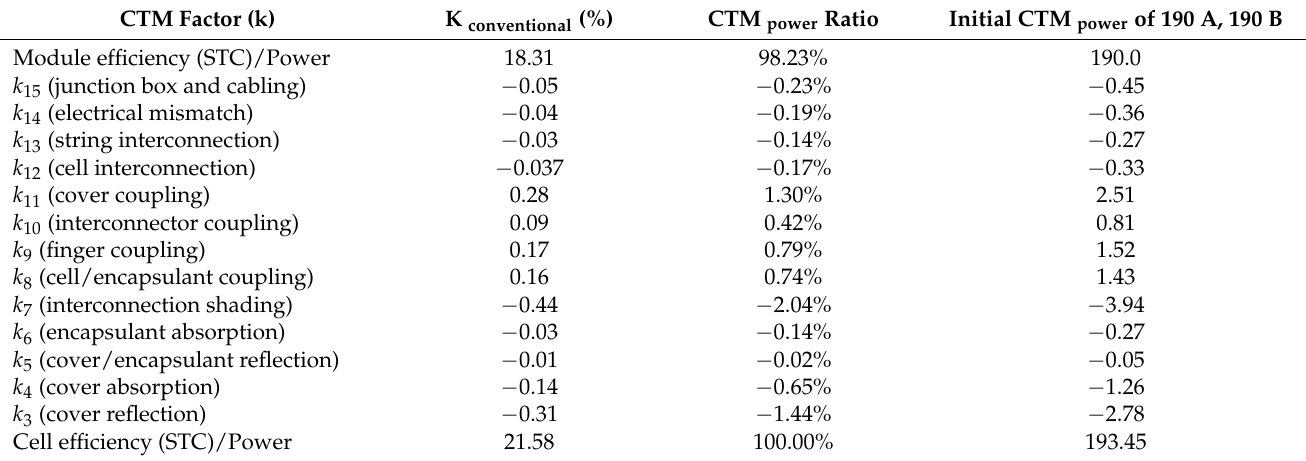
Table 3. Initial applied cell grade analysis of sample modules (190 A, 190 B) to be recovered.